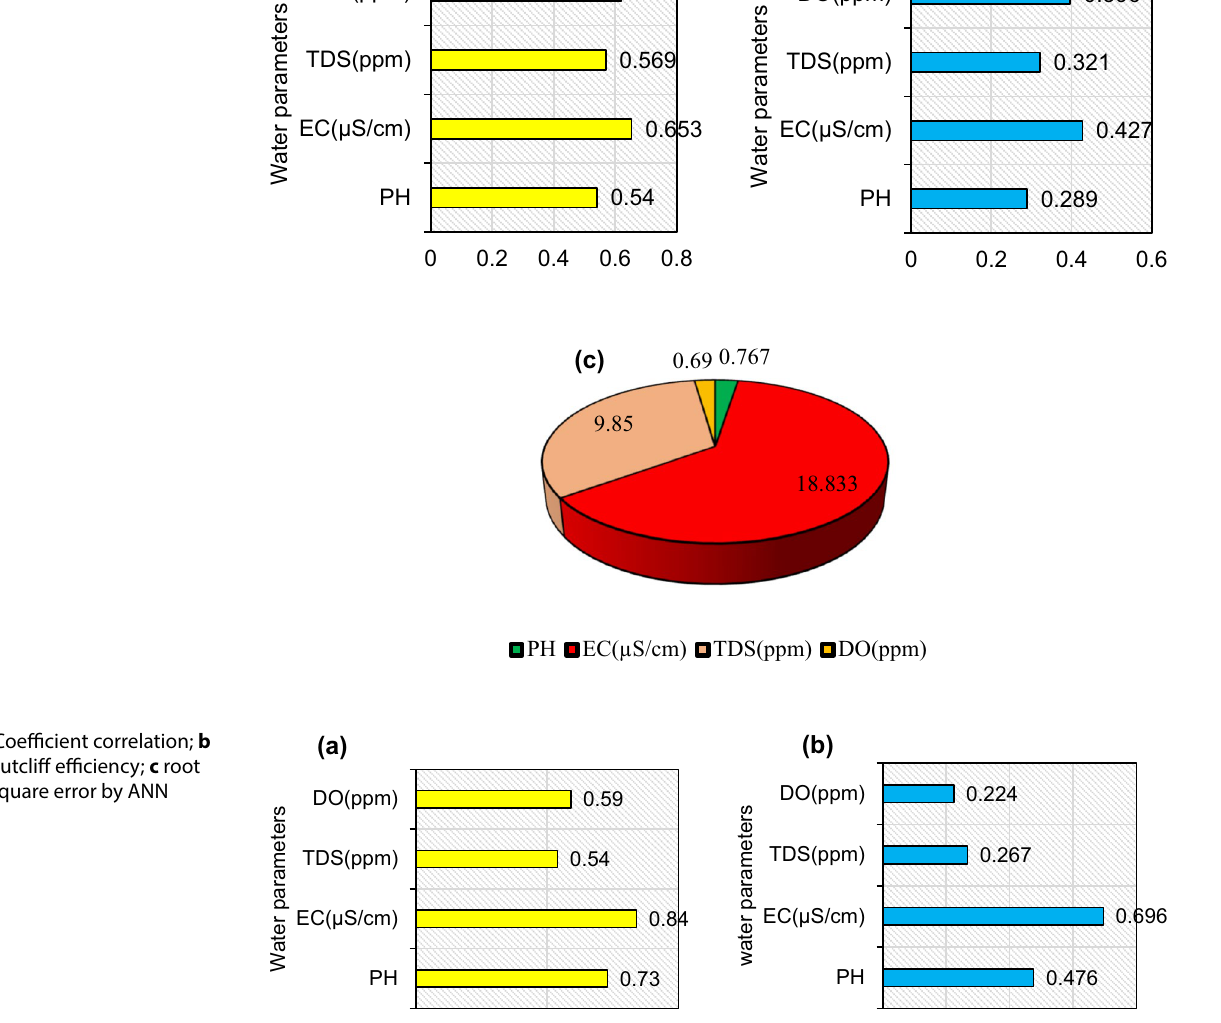
Fig. 6 a Coefficient correla- tion; b Nash–Sutcliff efficiency; c root mean square error by MLR.